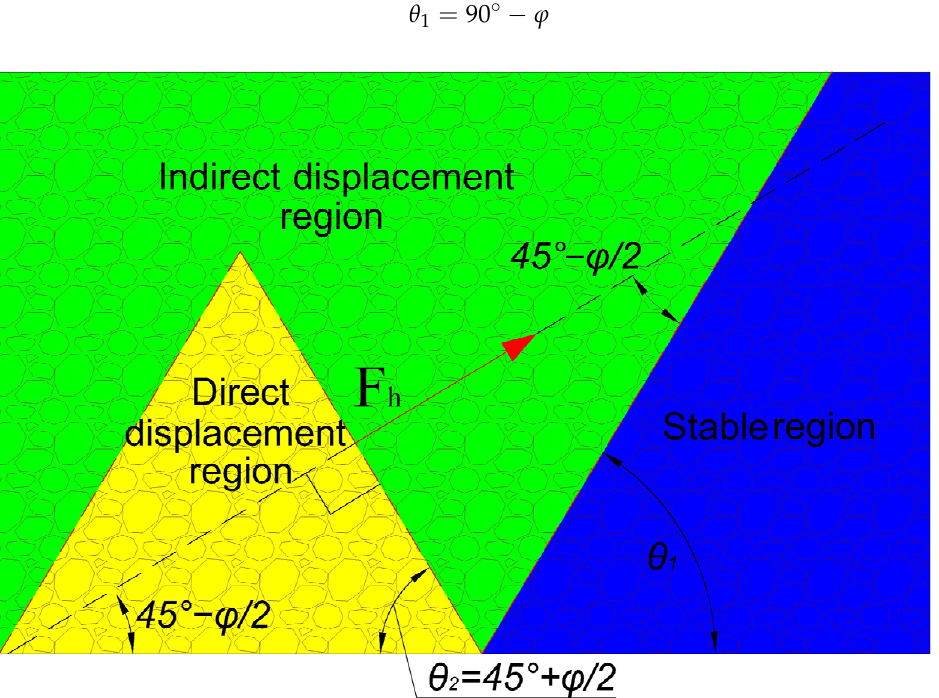
Figure 12. Force analysis of slip plane 1.